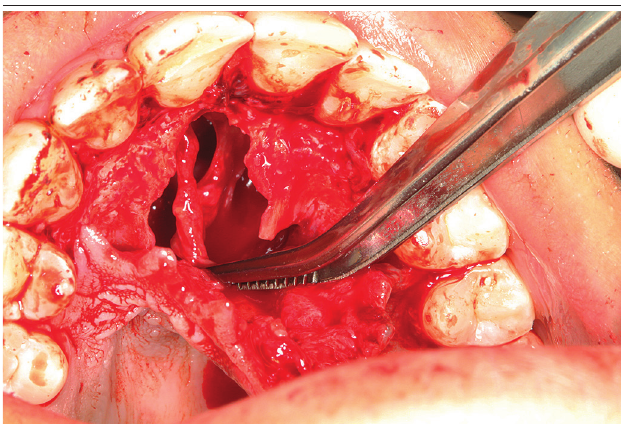
figurE 12 − Enucleation of the